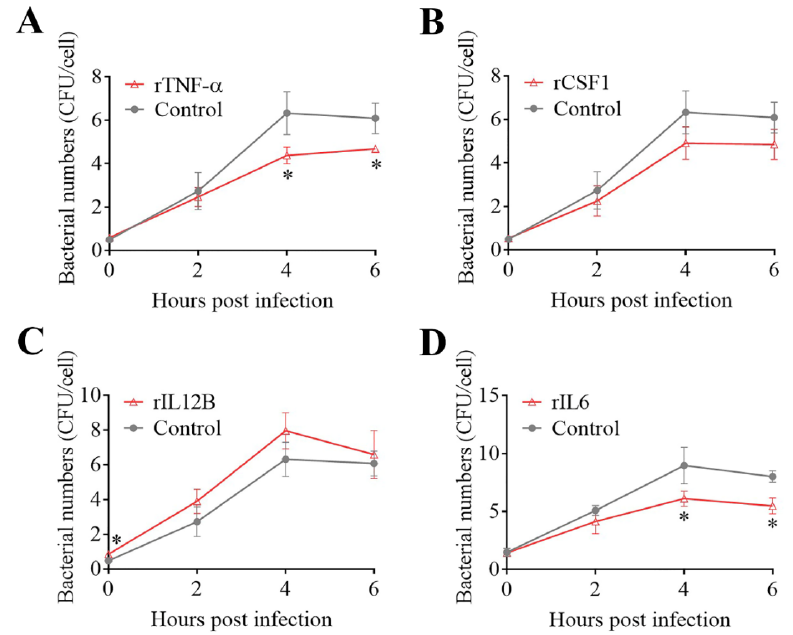
Figure 4. Effects of DECs on Edwardsiella tarda infection. RAW264.7 cells were pretreated with rTNF– α ( A ), rCSF1 ( B ), rIL12B ( C ), or rIL6 ( D ) and infected with E. tarda for 1 h, and the extracellular bacteria were killed by antibiotic treatment.